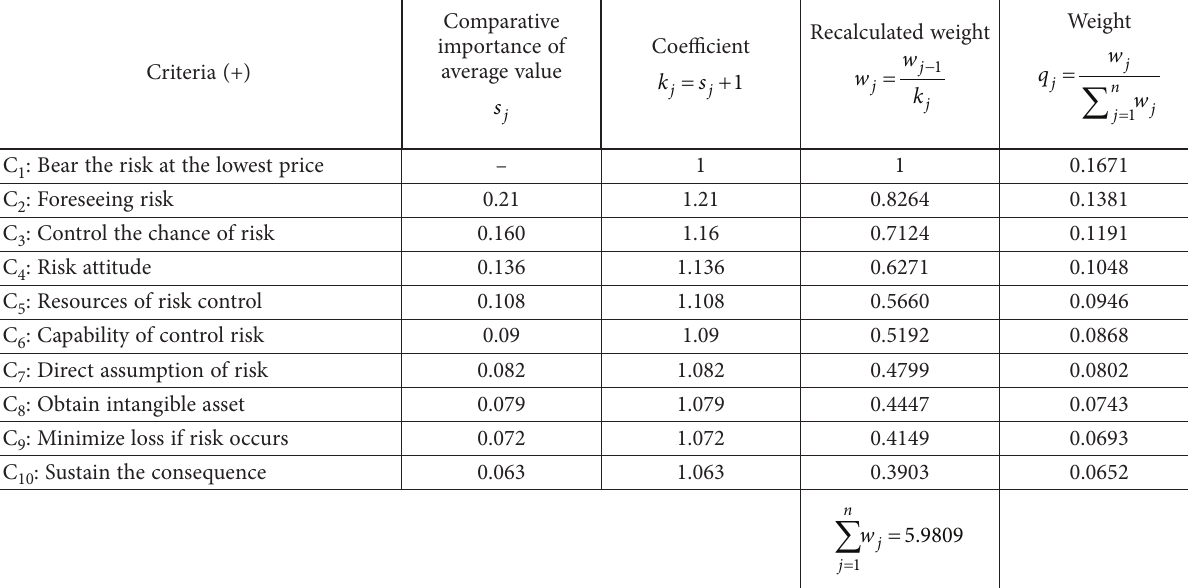
Table 6. The weight of risk allocation